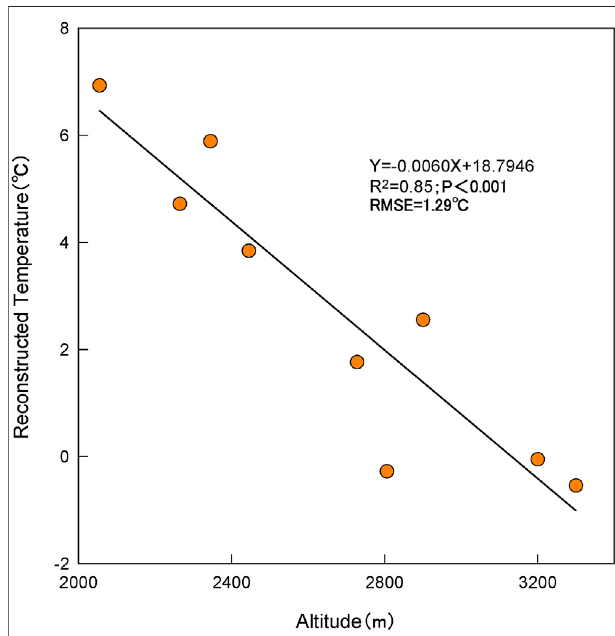
FIGURE 7 | Correlation between brGDGTs-derived temperature estimation and altitude of the Qilian Shan samples.